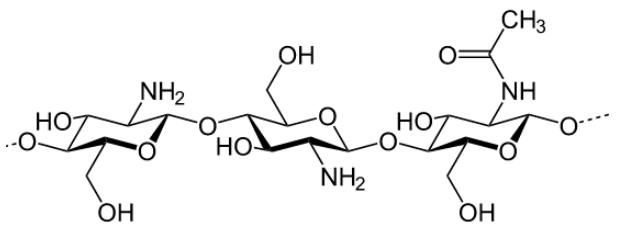
Figure 3. Chitosan structure.